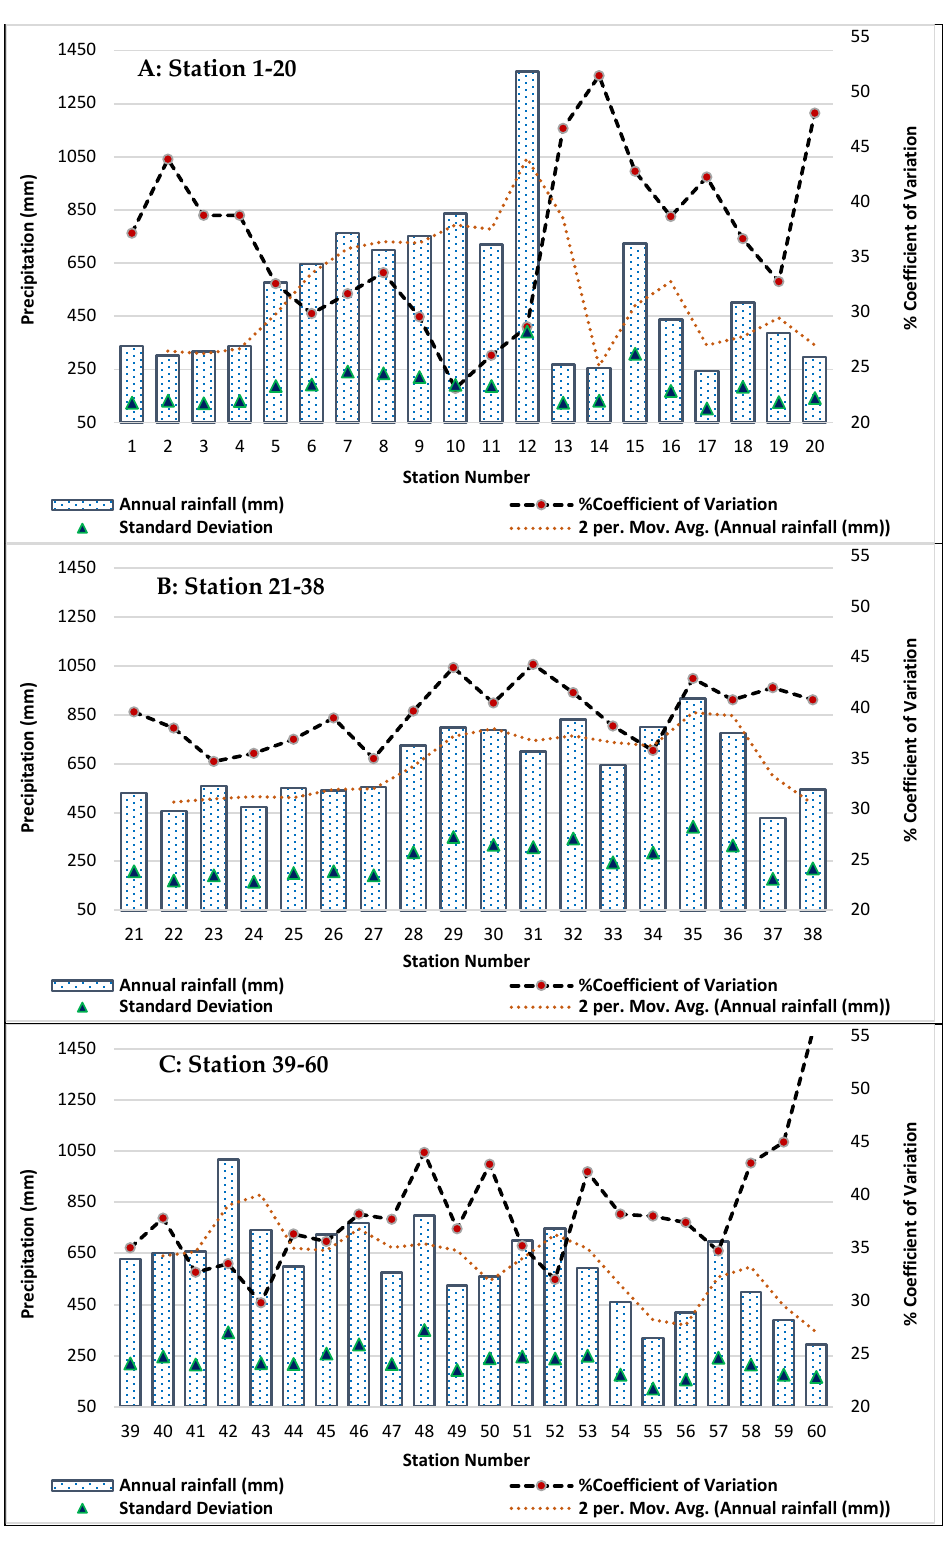
Figure 10. Descriptive statistics of the average annual precipitation series data recorded at each of the 60 weather stations.